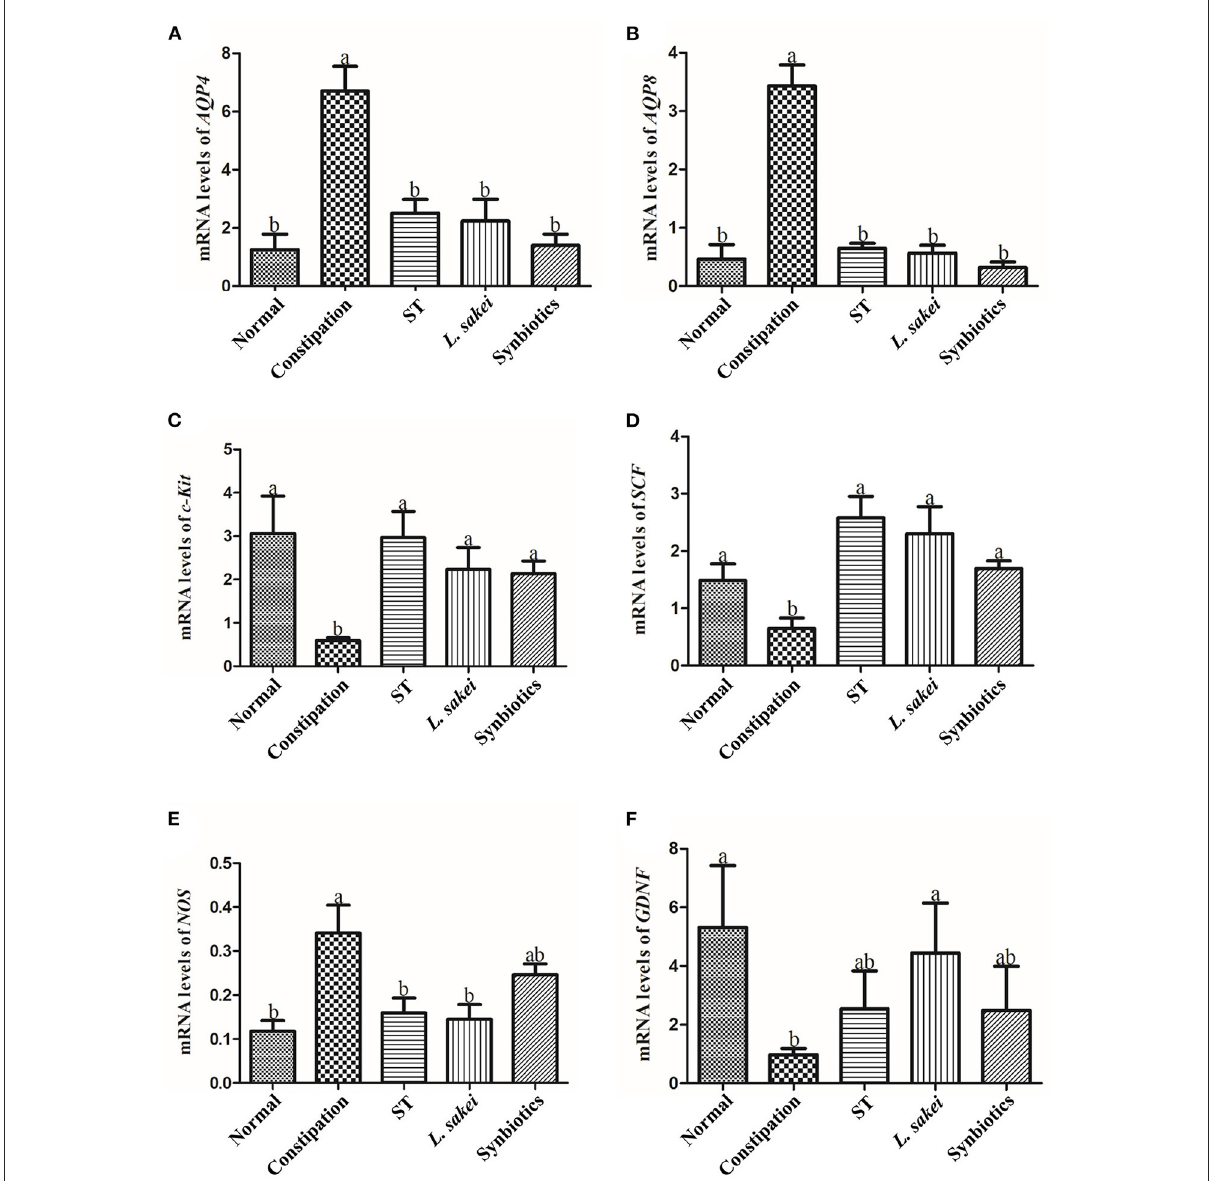
FIGURE2 The effect of ST or L. sakei alone or combined on the mRNA expression levels of constipation-related intestinal factors in mice. (A) Changes in mRNA levels of AQP4 ; (B) Changes in mRNA levels of AQP8 ; (C) Changes in mRNA levels of c-Kit ; (D) Changes in mRNA levels of SCF ; (E) Changes in mRNA levels of NOS ; (F) Changes in mRNA levels of GDNF . Data represent the mean ± SD ( n = 6). Statistical analysis was conducted using One-way ANOVA followed by Tukey’s multiple comparisons test for each group. Bars bearing different letters indicate a significant difference, P <